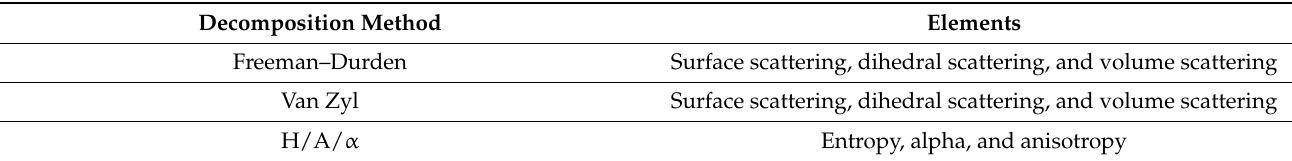
Table 4. Various polarimetric feature elements from different polarimetric decomposition